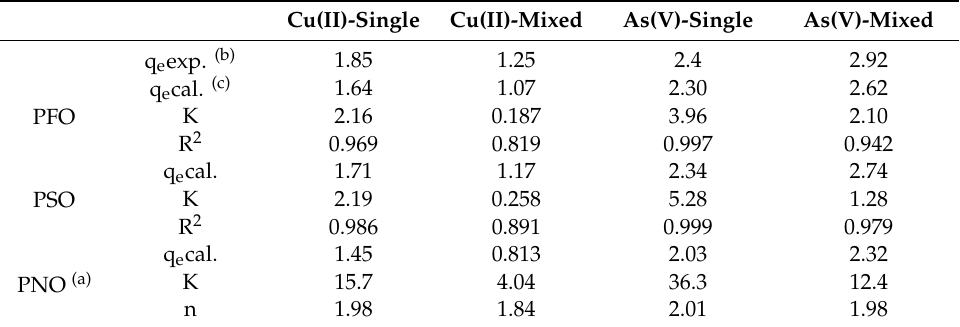
Table 1. Kinetic parameters using nonlinear PFO and PSO models for Cu(II) and As(V) in single and mixed solutions.